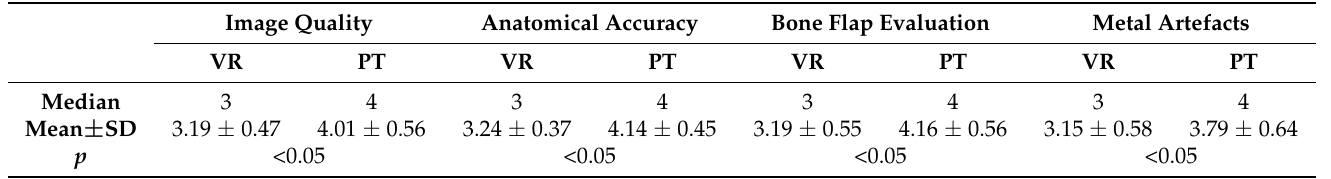
Table 4. Results of the Likert’s scale evaluation of ll readers considered together (VR = volume rendering; PT = path tracing; SD = standard deviation).